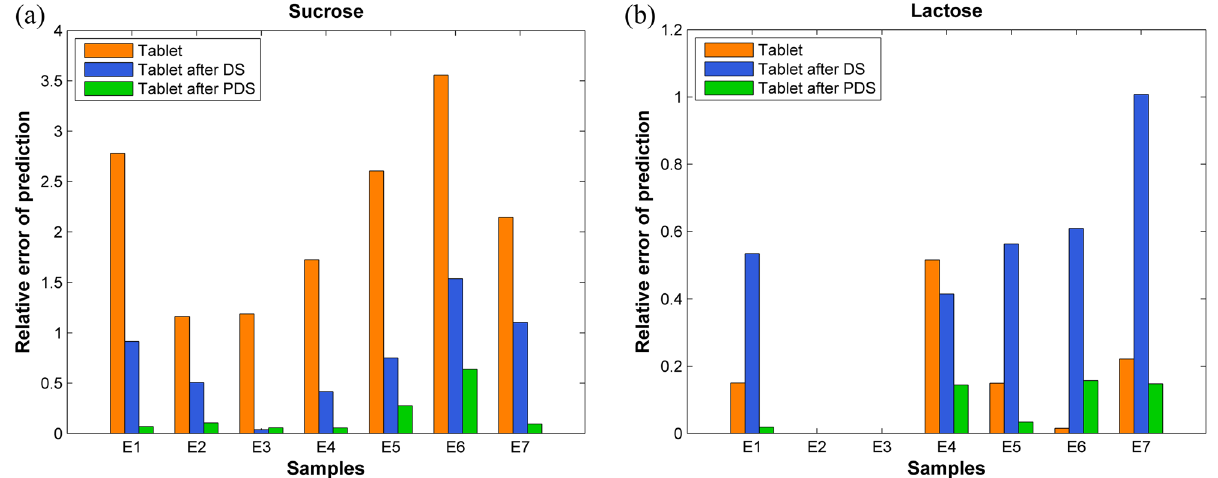
Figure 4. Comparison between the prediction results before and after the DS and PDS transformations of the real milk